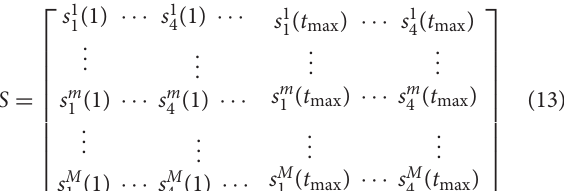
or “synergies” and M was the maximal number of synergies. The of U , m -by- m of 6 (the other values are replaced by zeros), and the weight